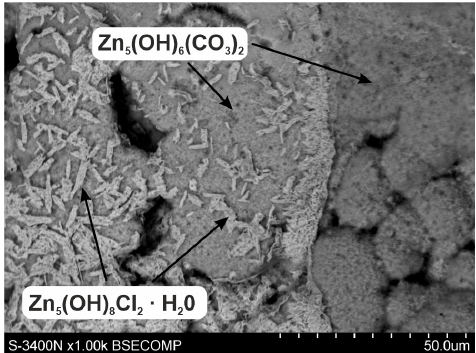
Figure 11. SEM images of the corroded ZAMS coating in the simonkolleite transformation area—